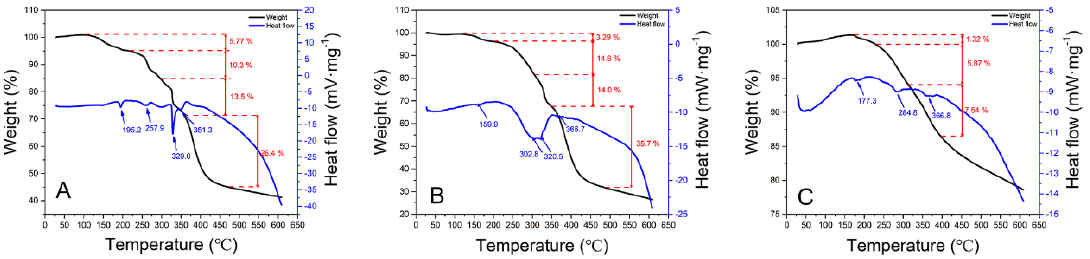
Figure 4. TGA-DSC analysis of ( A ) APAM-Fe 3 O 4 , ( B ) TAPAM-Fe 3 O 4 and ( C ) TAPAM-PDA-Fe 3 O 4 .